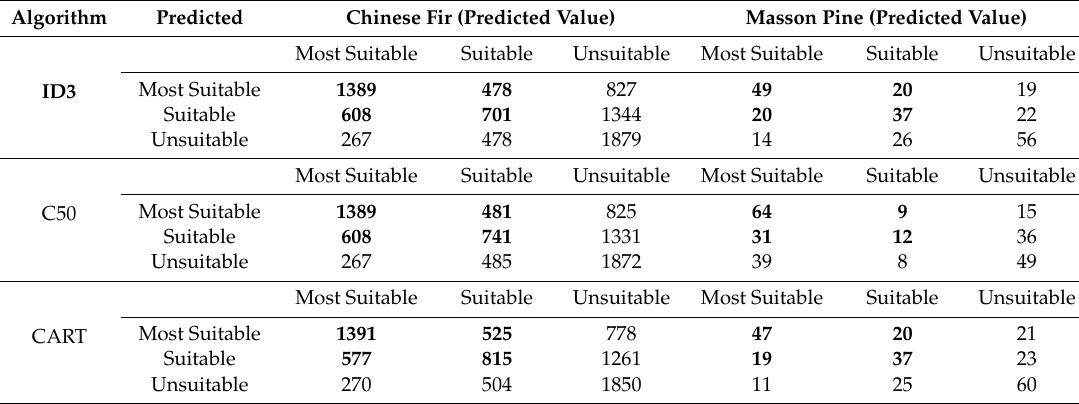
Table 8. The coincidence matrix of three algorithms for Chinese fir and Masson